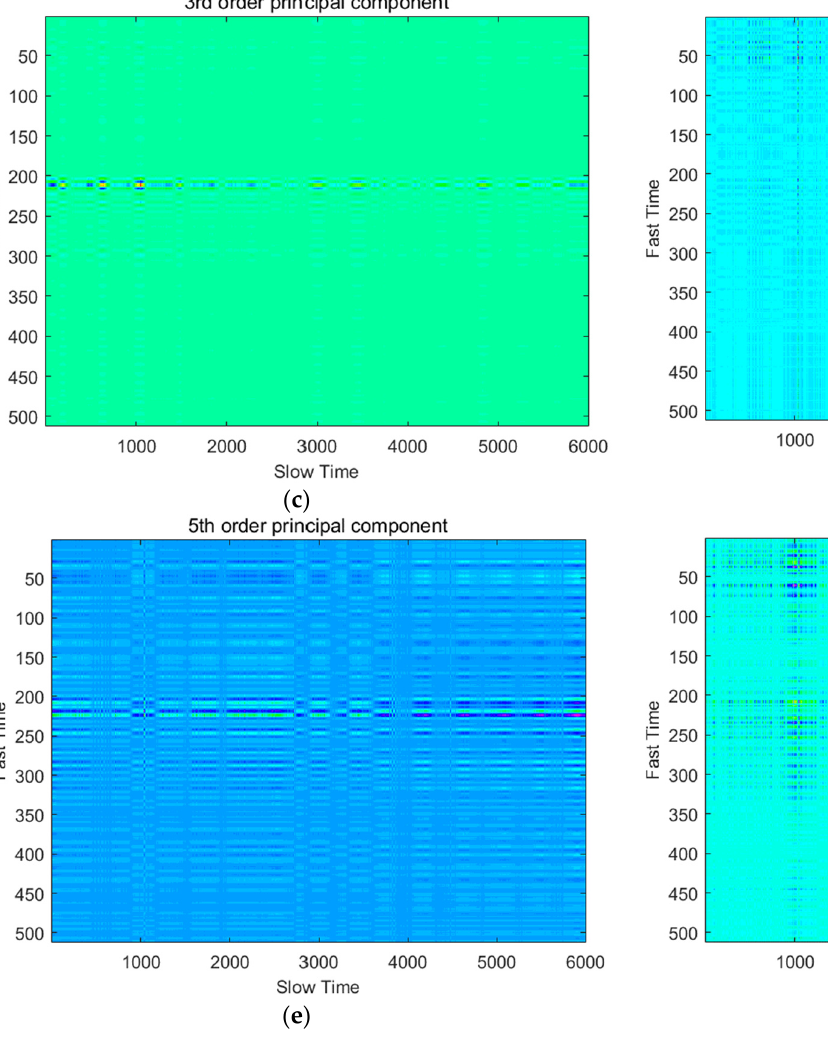
Figure 8. SVD Data denoising and dimensionality reduction effect: ( a ) First order principal compo- nent; ( b ) second order principal component; ( c ) third order principal component; ( d ) fourth order principal component; ( e ) fifth order principal component; ( f ) sixth order principal